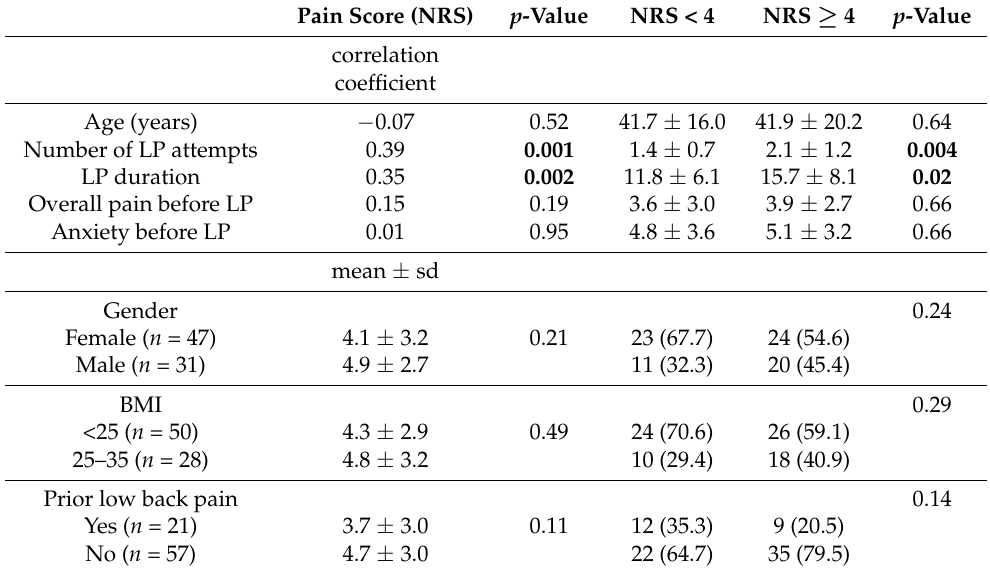
Table 4. Predictive factors for LP-induced